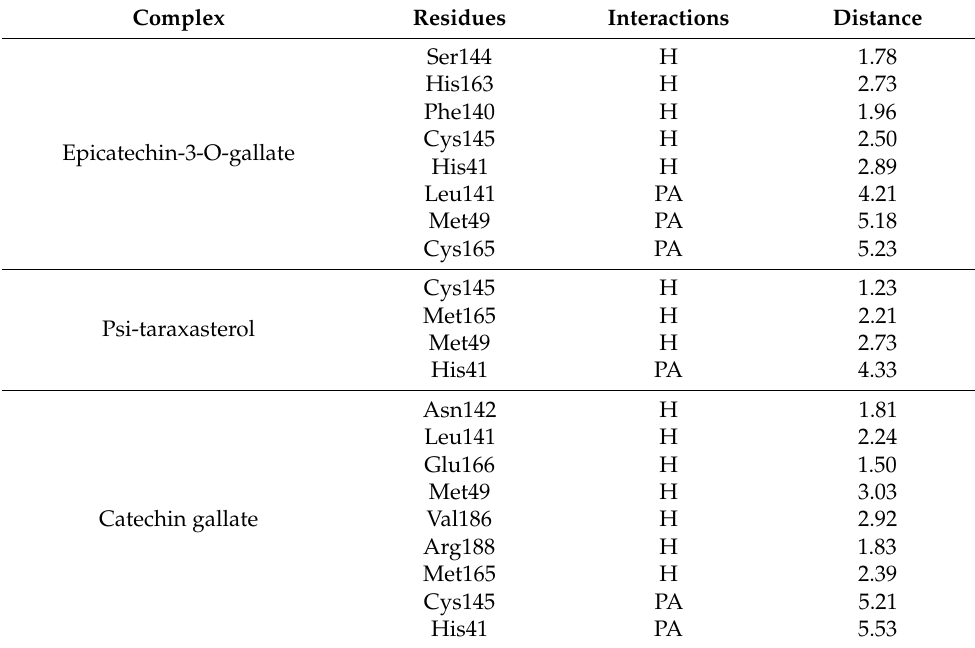
Table 3. The binding interactions of the docked complex after 100 ns in the molecular dynamics simulation study. H indicates hydrogen and PI indicates pi-alkyl